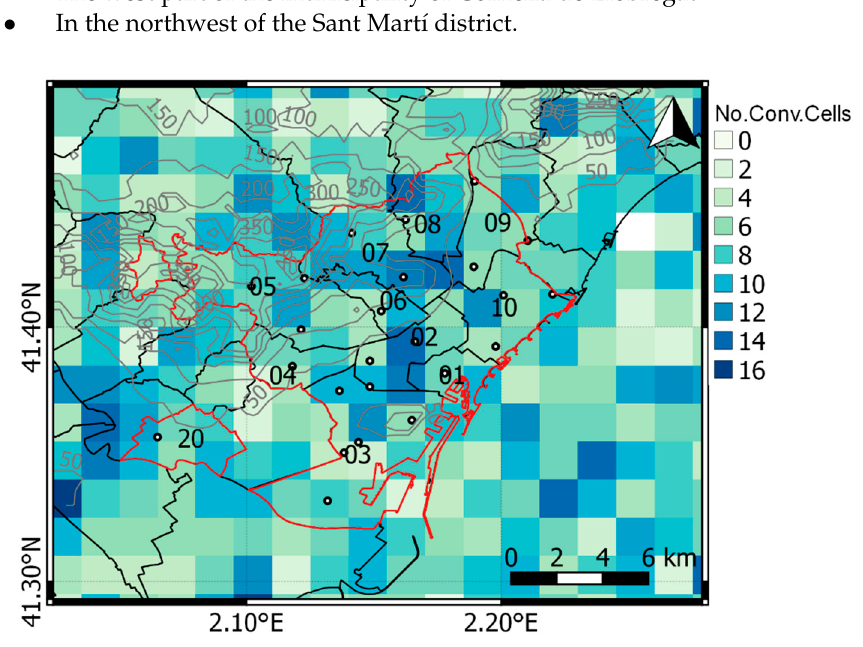
Figure 8. Distribution of centroids of convective cells for significant episodes. The numbers refer to Barcelona districts, and they are detailed on Figure 6.